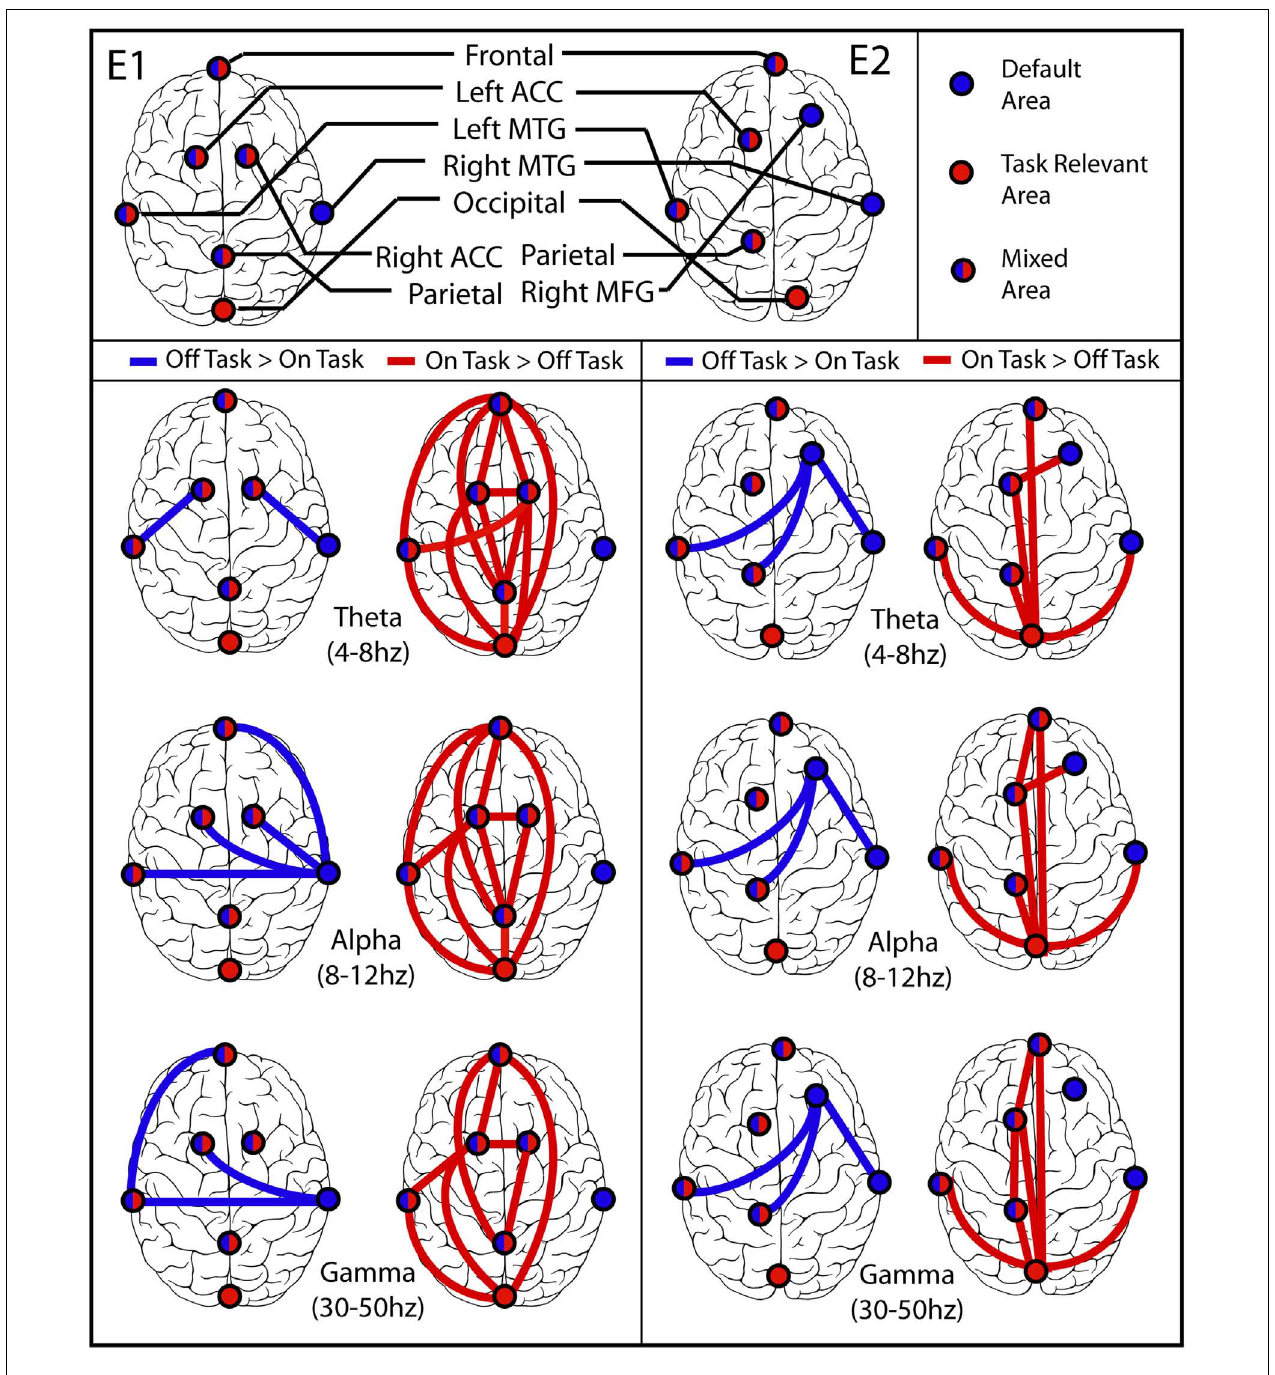
off-task > on-task network, lines are displayed only if both the difference between average PLV was significant at p = 0.001 in the indicated direction and the more significant coherence was also significantly different from zero for most or all of the subjects in the cluster by binomial test at p = 0.001.The off-task network in Experiment 2 passed only the first of these